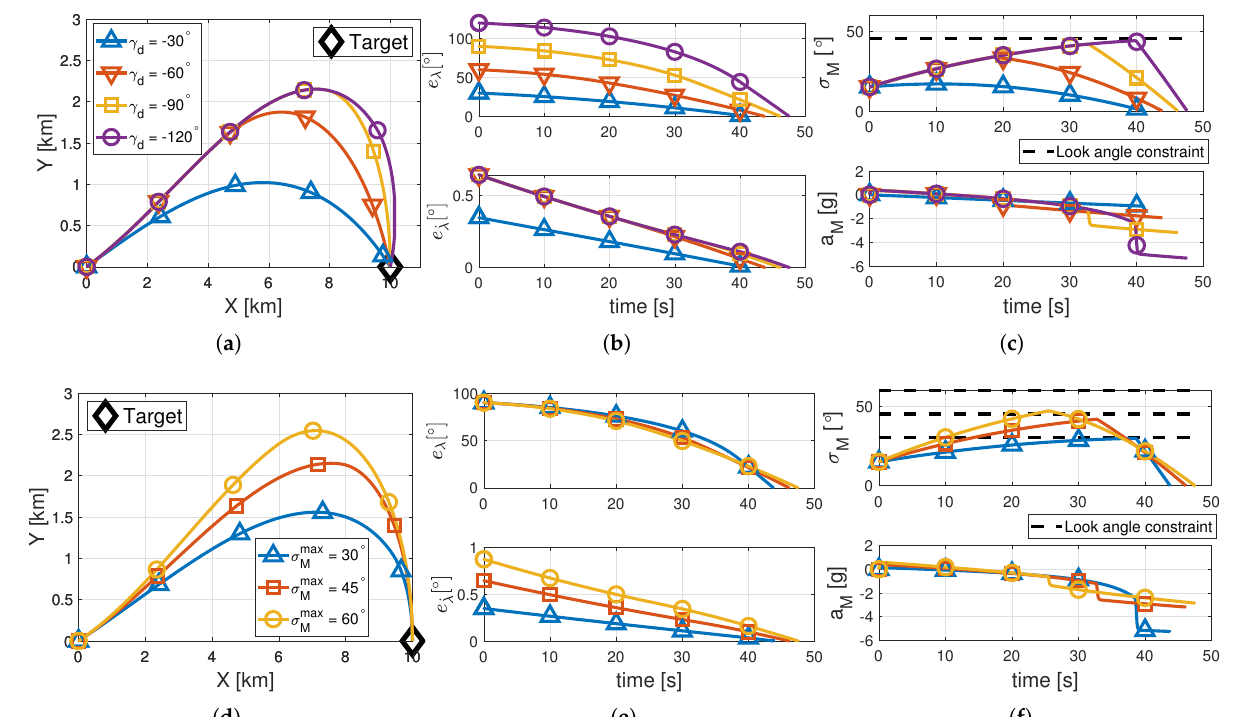
Figure 3. Simulation results of the proposed law for various impact angle and look angle constraints. ( a ) Flight trajectories. ( b ) Error variables. ( c ) Look angles and normal accelerations. ( d ) Flight trajectories. ( e ) Error variables. ( f ) Look angles and normal